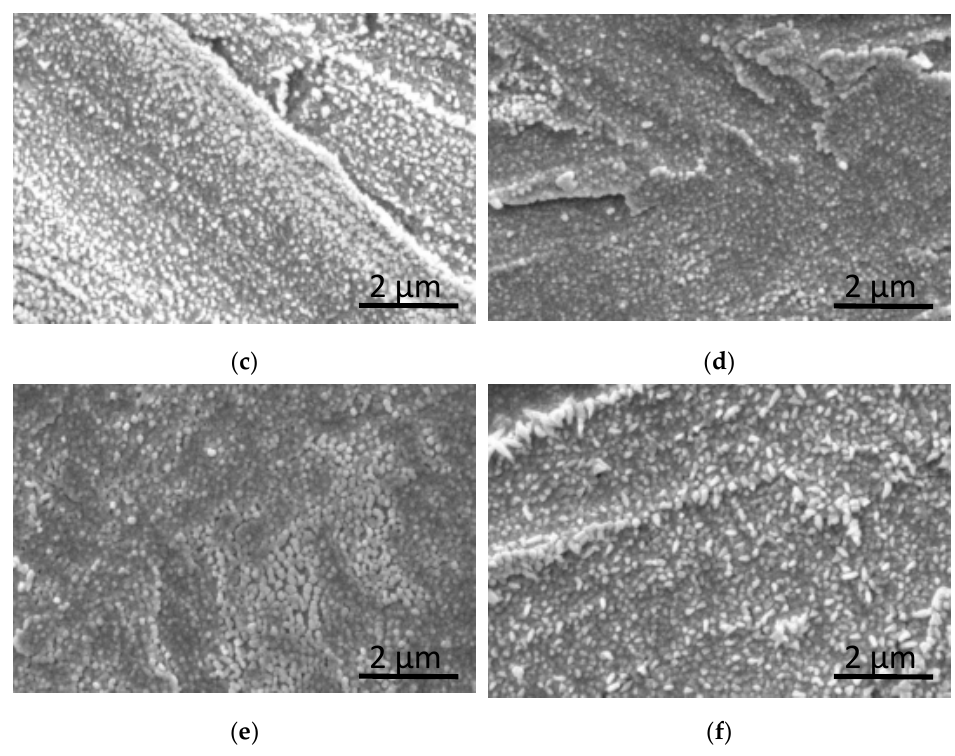
Figure 3. SEM image of the surface and section of the tin plating( a , c , e ) containing cerium nitrate; ( b , d , f ) not containing cerium nitrate;( a , c , d ) before treatment; ( b , e , f ) after treatment.